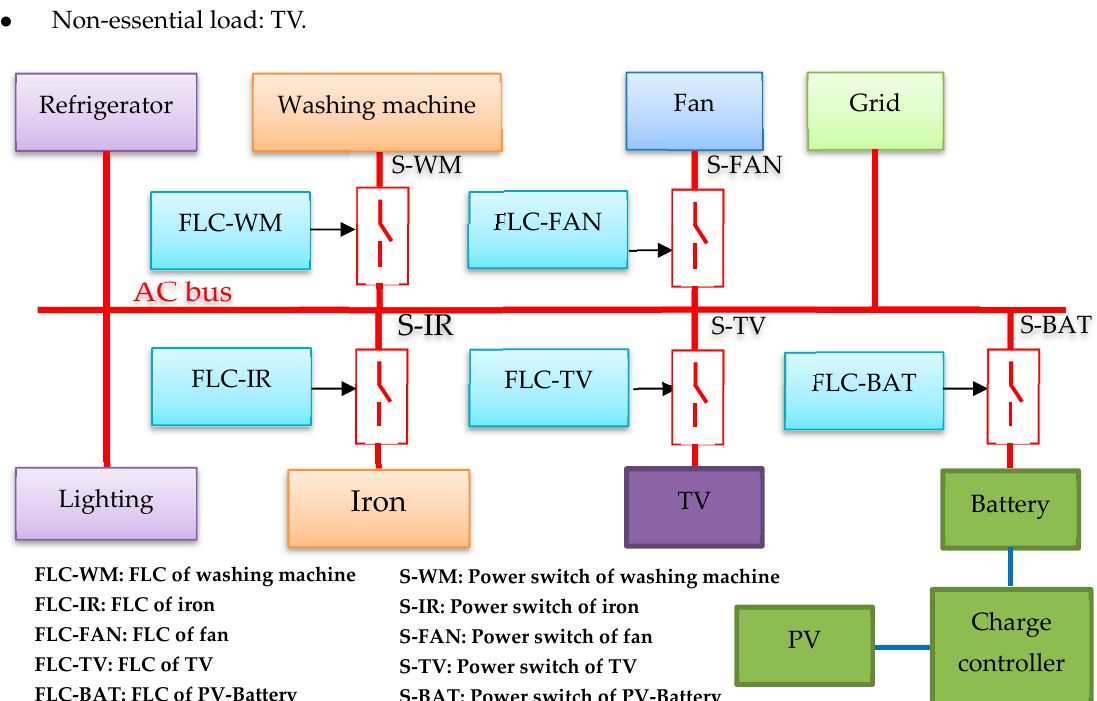
Figure 1. The architecture of electrical system.